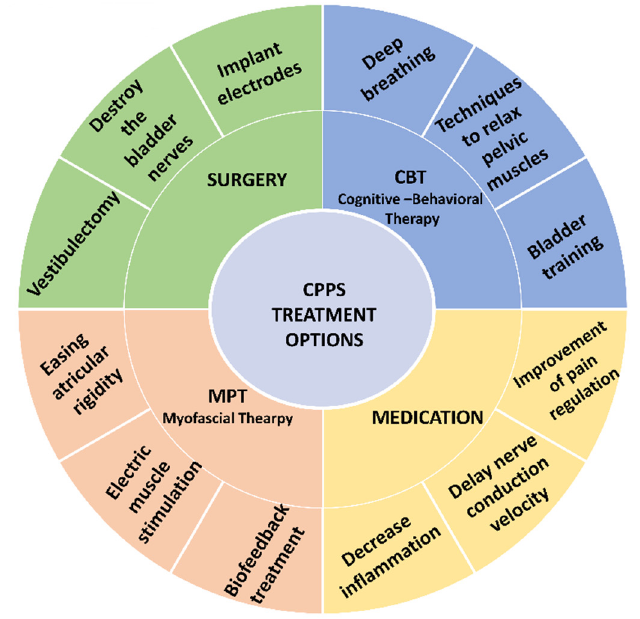
Figure 2. Multidisciplinary treatment options for CPPS.